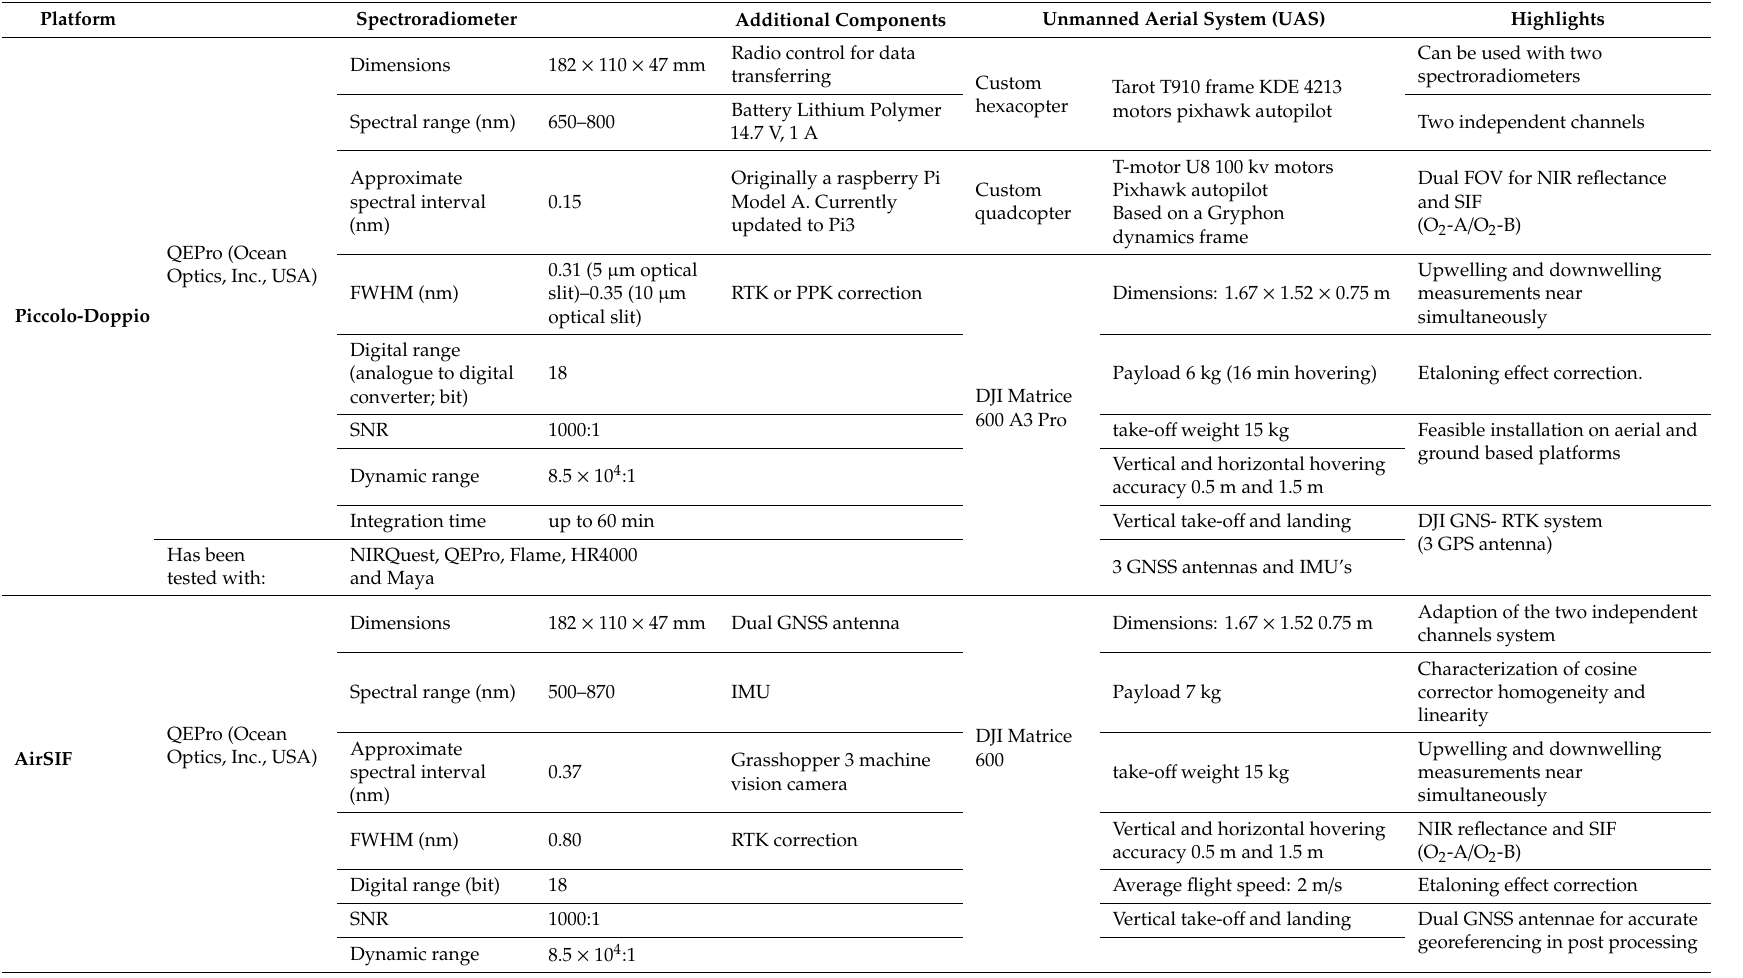
Table 1. Summary of the main characteristics of the spectroradiometer and UAS utilized for each